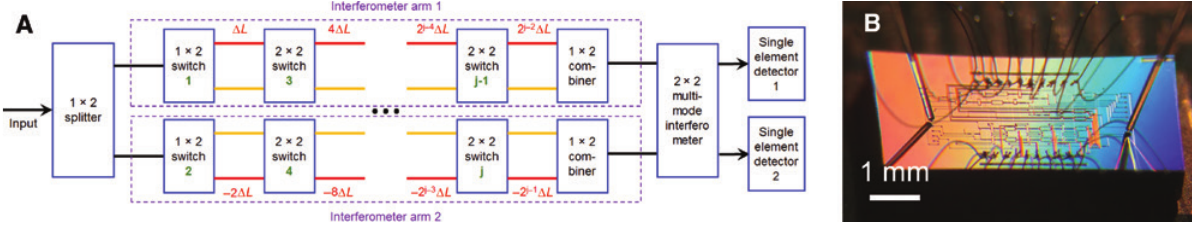
Figure 15: dFTIR spectrometer.